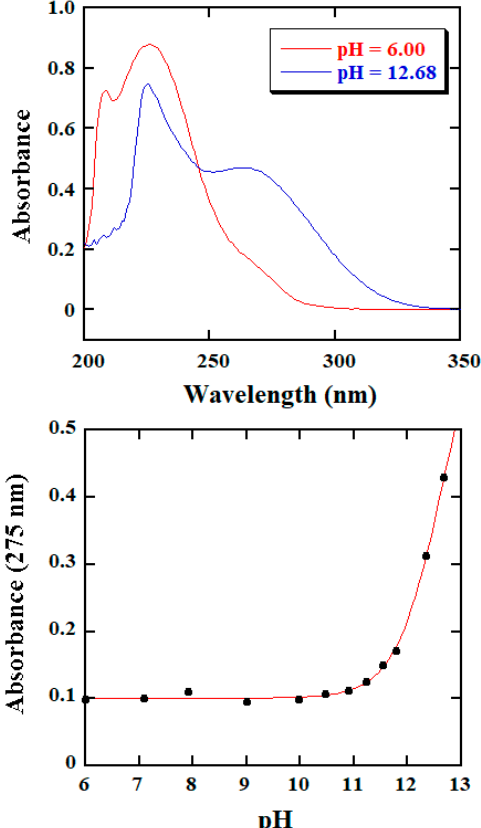
Figure 8. ( Top ): UV-vis spectra of 0.10 mM BH in two buffers of different pH at 25.0 °C and μ = 1.0 M. ( Bottom ): Absorbance at 275 nm of 0.10 mM BH solutions as function of pH at 25.0 °C and μ = 1.0 M. The solid curve was obtained from the best fit of Equation (6) to the experimental data using a nonlinear least-squares method.